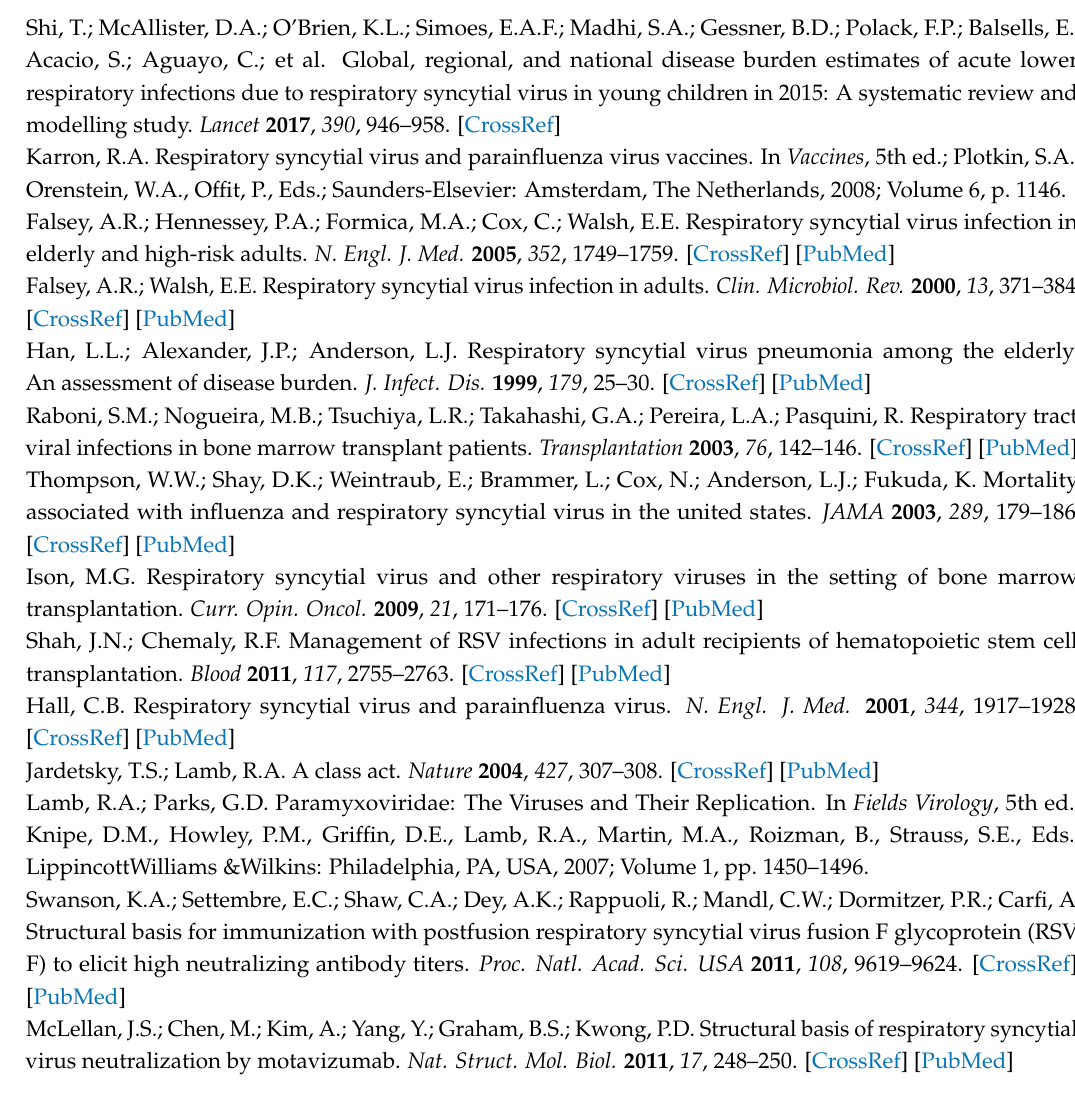
Figure S1: Western blot of protein content of VLPs prior to adjustment for equivalent amounts of F protein. Figure S2: Relative binding of representative mAbs to purified VLPs. Figure S3: Blocking of binding of mAb by sera harvested at different times. Figure S4: Binding of sera induced by DS-Cav1 or SC-TM VLPs to the soluble DS-Cav1 protein or soluble SC-TM protein. Table S1: Relative concentrations of VLP proteins in different VLP